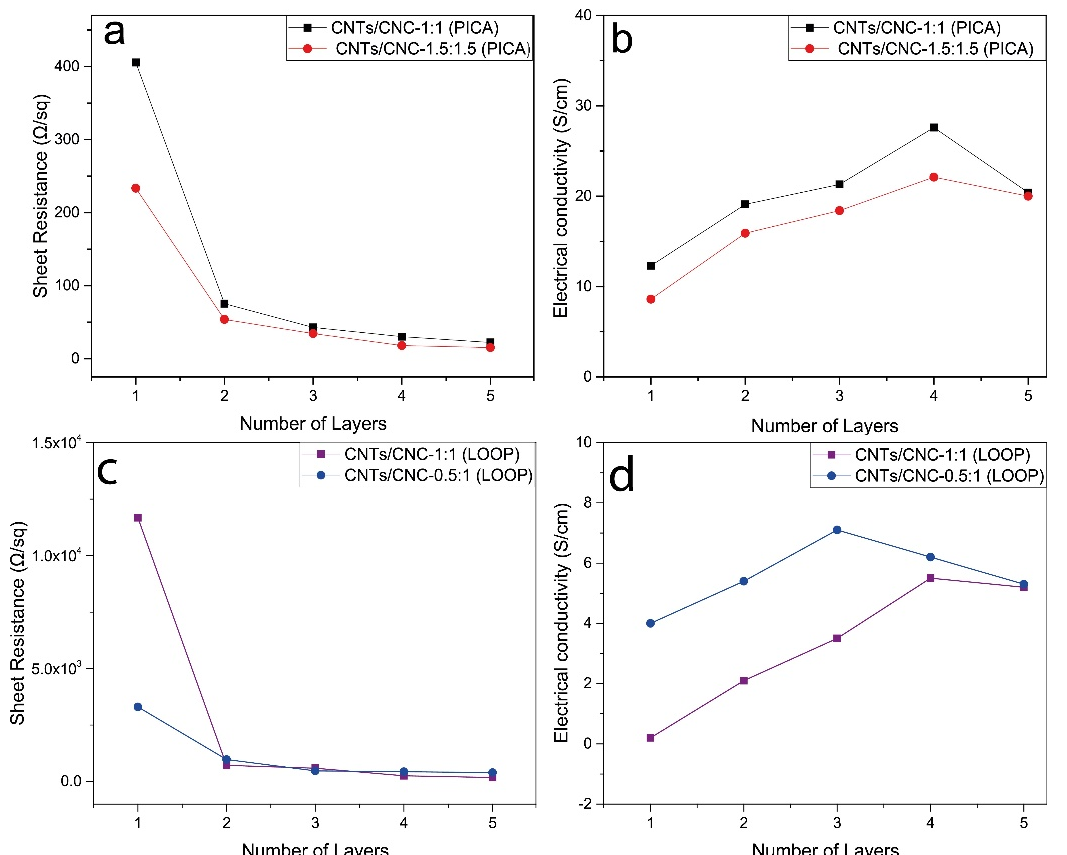
Figure 10. Resistance and electrical conductivity of CNTs/CNC printed samples concerning the number of printed layers; ( a , b ) CNTs/CNC—1:1 and CNTs/CNC—1.5:1.5 printed PICA designs, ( c , d ) CNTs/CNC—0.5:1 and CNTs/CNC—1:1 printed LOOP antenna as a function of deposited conductive layers.